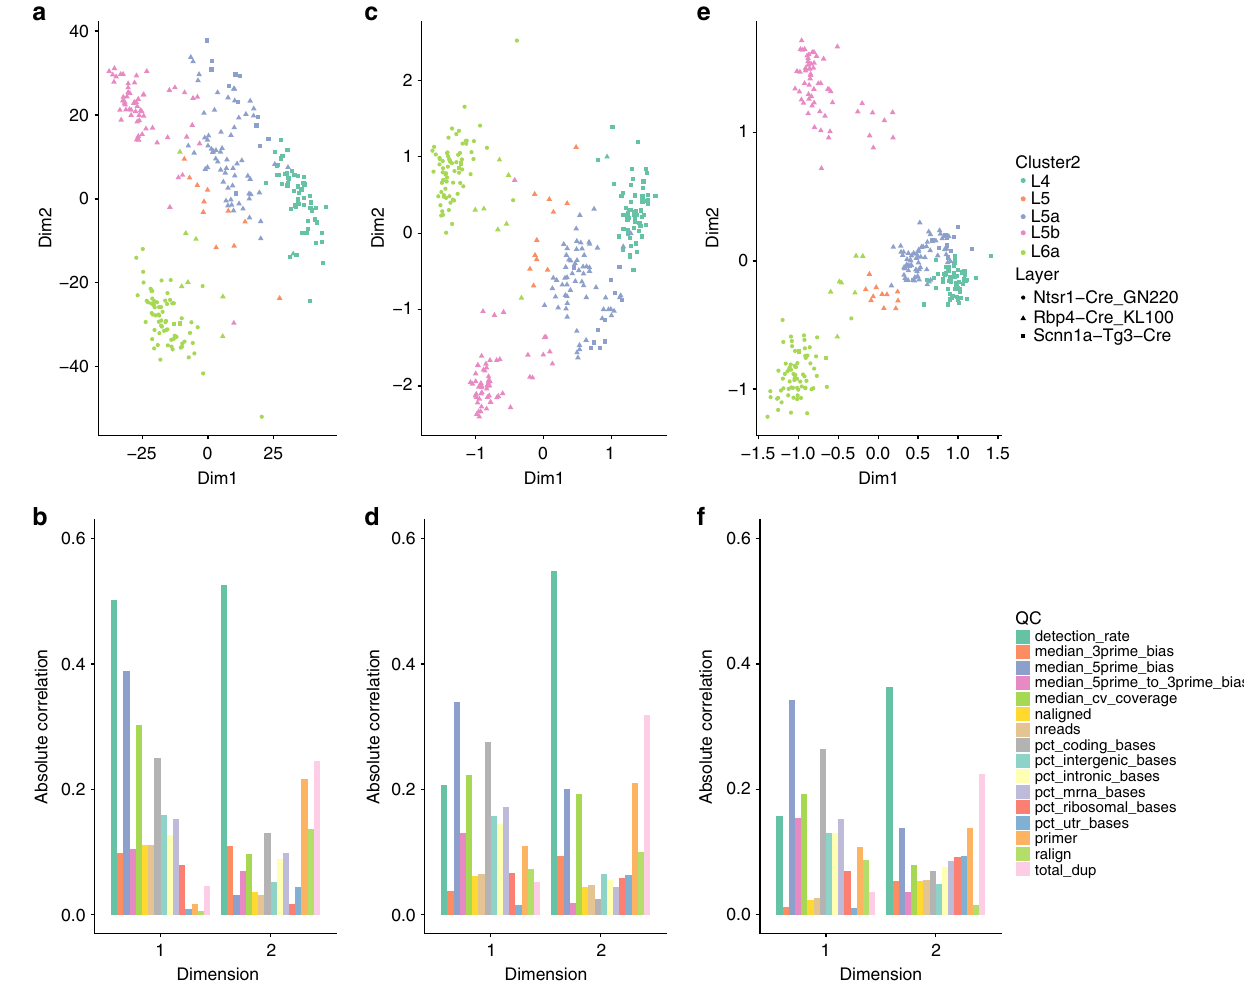
Fig. 2 Low-dimensional representation of the V1 data set. Upper panels provide two-dimensional representations of the data, after selecting the 1000 most variable genes. Lower panels provide barplots of the absolute correlation between the fi rst two components and a set of QC measures (see Methods). a , b PCA (on TC-normalized counts). c , d ZIFA (on TC-normalized counts). e , f ZINB-WaVE (no normalization needed). ZINB-WaVE leads to a low-dimensional representation that is less in fl uenced by technical variation and to tighter, biologically meaningful clusters. The ZINB-WaVE projection was robust to the number of genes selected (Supplementary Fig.